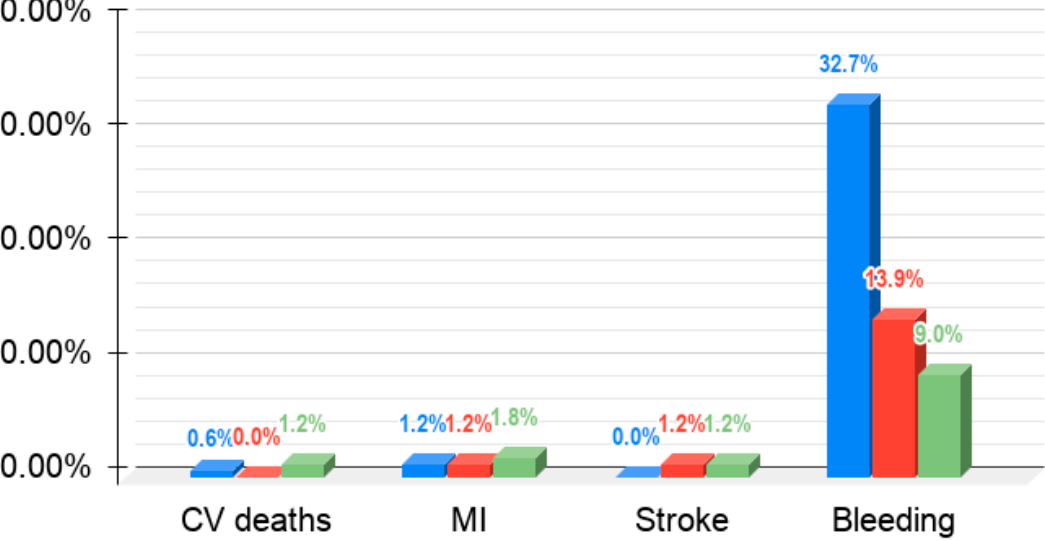
Figure 3. Postoperative complications after CABG with different treatment regimens. CV deaths—cardiovascular deaths; MI—myocardial infarction.